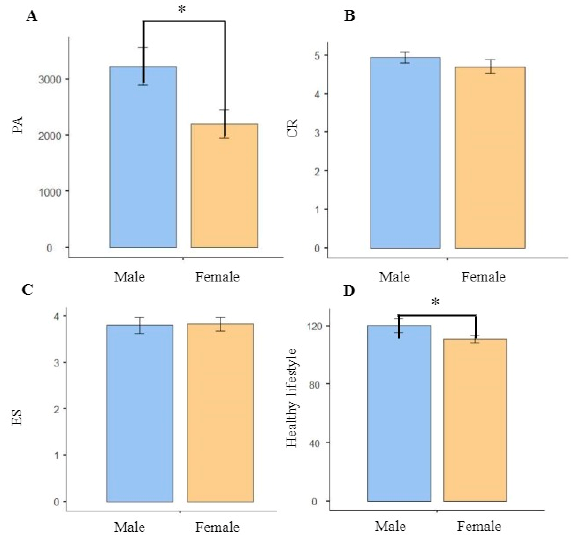
Figure 1. ( A ) Comparison graph of male and female in PA. ( B ) Comparison graph of male and female in CR. ( C ) Comparison graph of male and female in ES. ( D ) Comparison graph of male and female in healthy lifestyle. Abbreviations: PA, physical activity; CR, cognitive reappraisal; ES, expressive suppression. Note: * Denotes significant differences at p < 0.05.